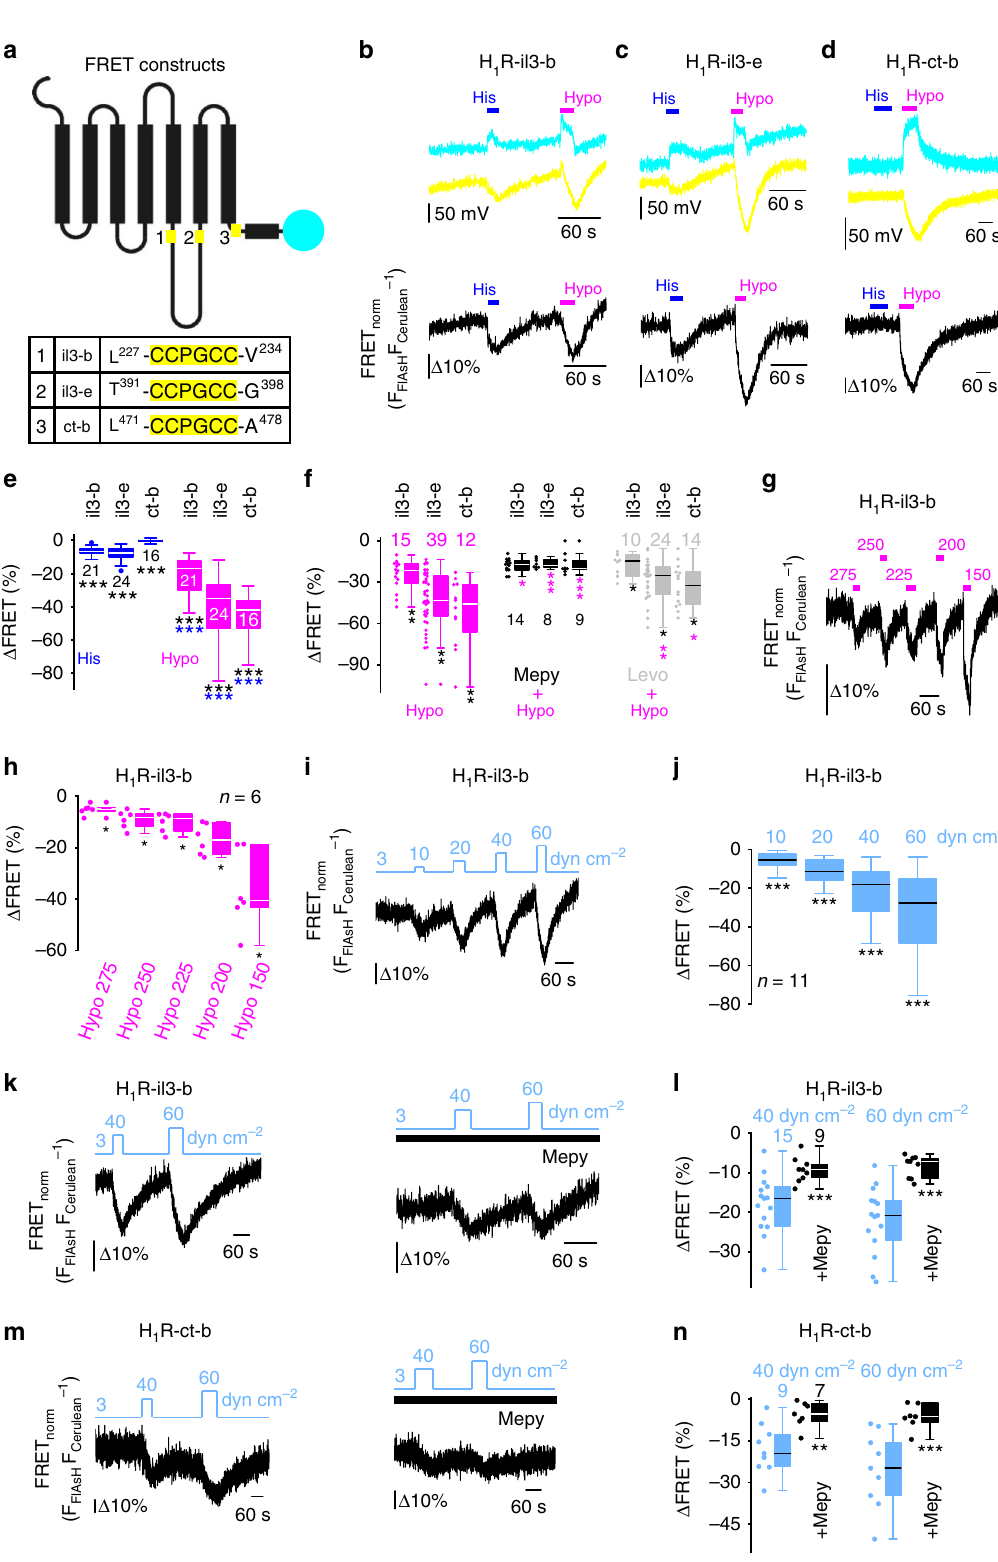
(Fig. 3a) and by electrophysiological whole-cell measurements 49 with HEK293 cells co-expressing the receptor-operated transient receptor potential classical cation channel 6 (TRPC6) as a readout system (Fig. 3b). Wild-type H 1 Rs responded to histamine with prominent TRPC6 current increases (Fig. 3c). Mechanically and TRPC6 channel activator 1-oleoyl − 2-acetyl-sn-glycerol